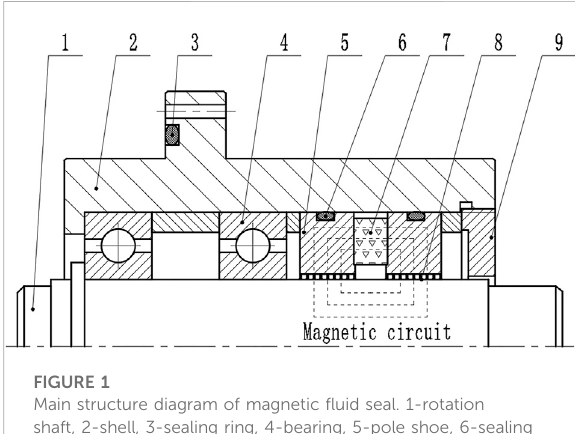
FIGURE 1 Main structure diagram of magnetic fl uid seal. 1-rotation shaft, 2-shell, 3-sealing ring, 4-bearing, 5-pole shoe, 6-sealing ring, 7-permanent magnet, 8-magnetic fl uid, 9-end